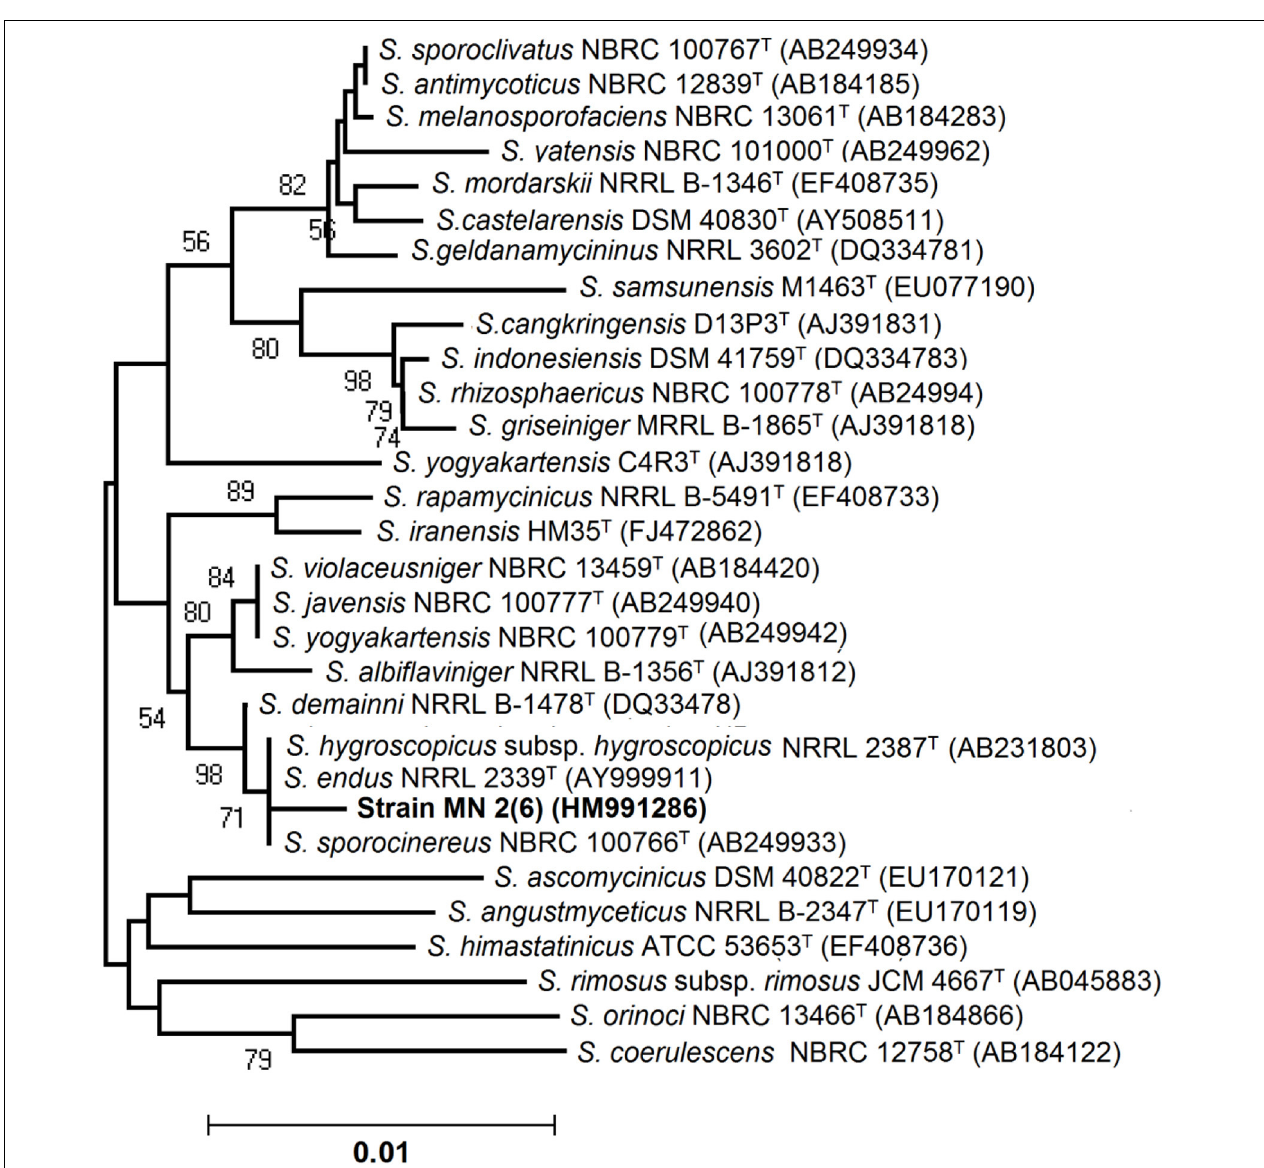
FIGURE 2 | Neighbor-joining tree showing the relationship between strain MN 2(6) and closely related members of the genus Streptomyces based on 16S rRNA gene sequences. Bootstrap